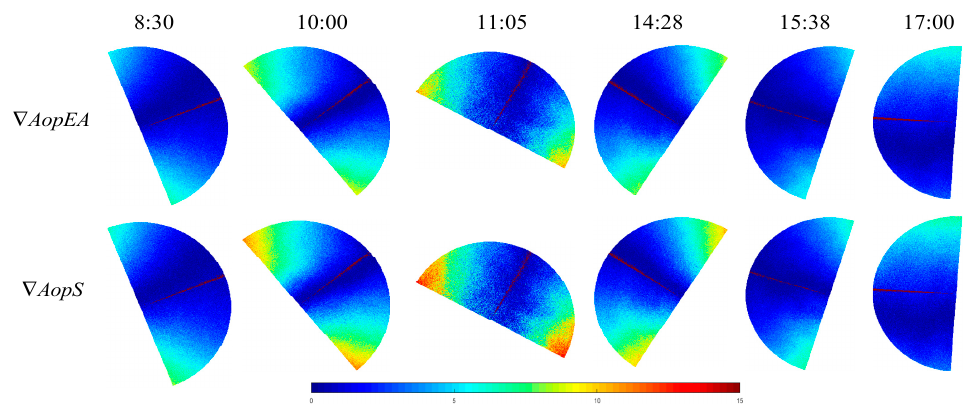
Figure 12. The result of consistency after experimental improvement.